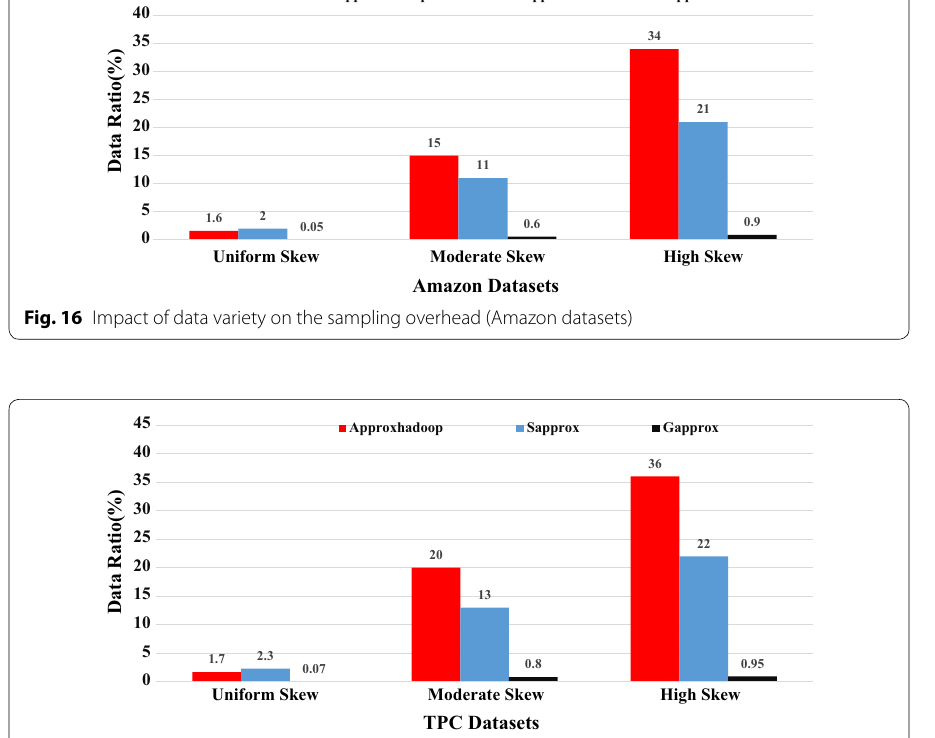
Fig. 17 Impact of data variety on the sampling overhead (TPC